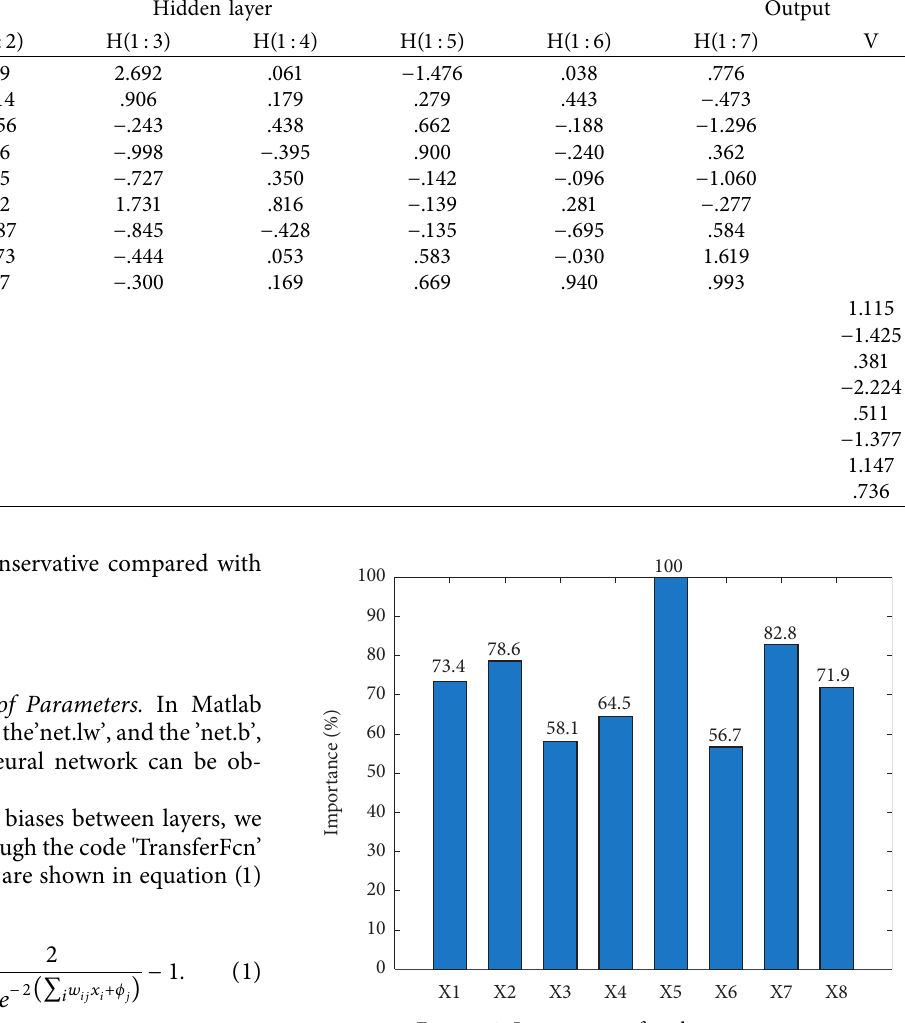
Figure 4: Importance of each